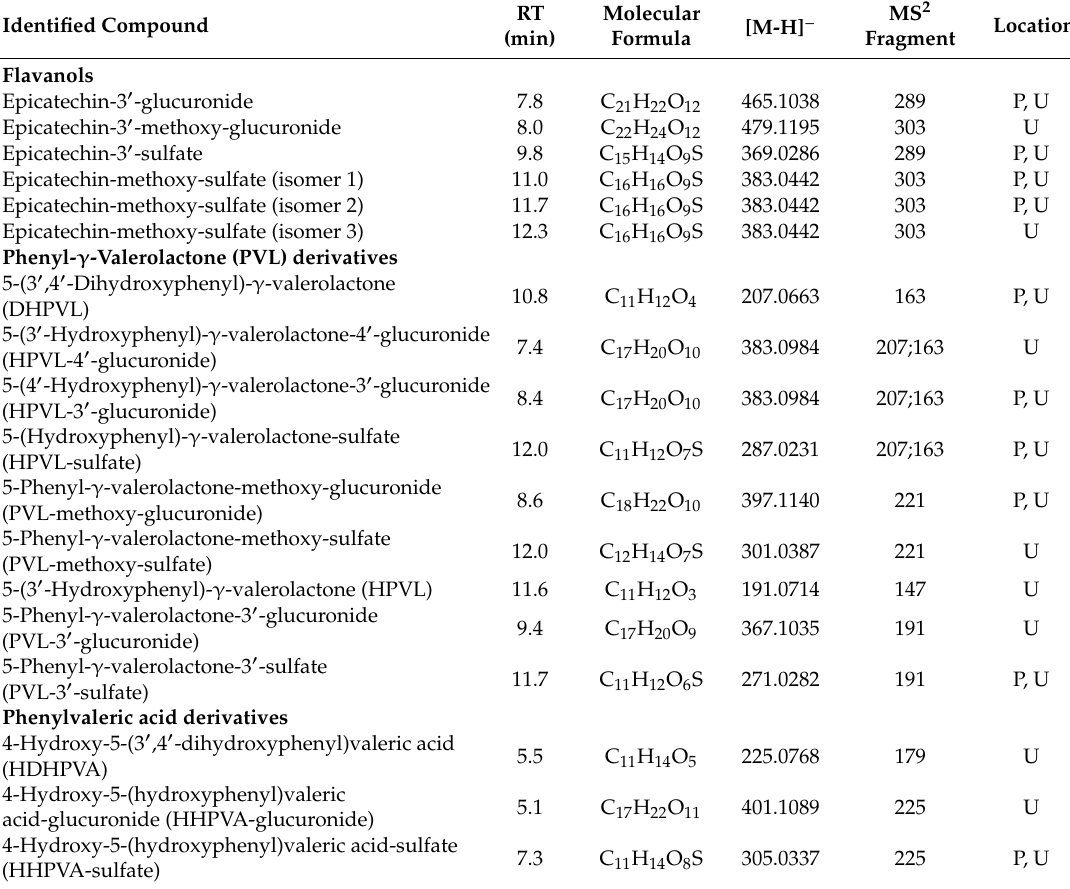
Table 2. High-performance liquid chromatography coupled to electrospray ionisation and quadrupole time-of-flight mass spectrometry (HPLC-ESI-QToF-MS) identification of flavanol metabolites detected in plasma (P) and urine (U) samples obtained after the ingestion of soluble cocoa